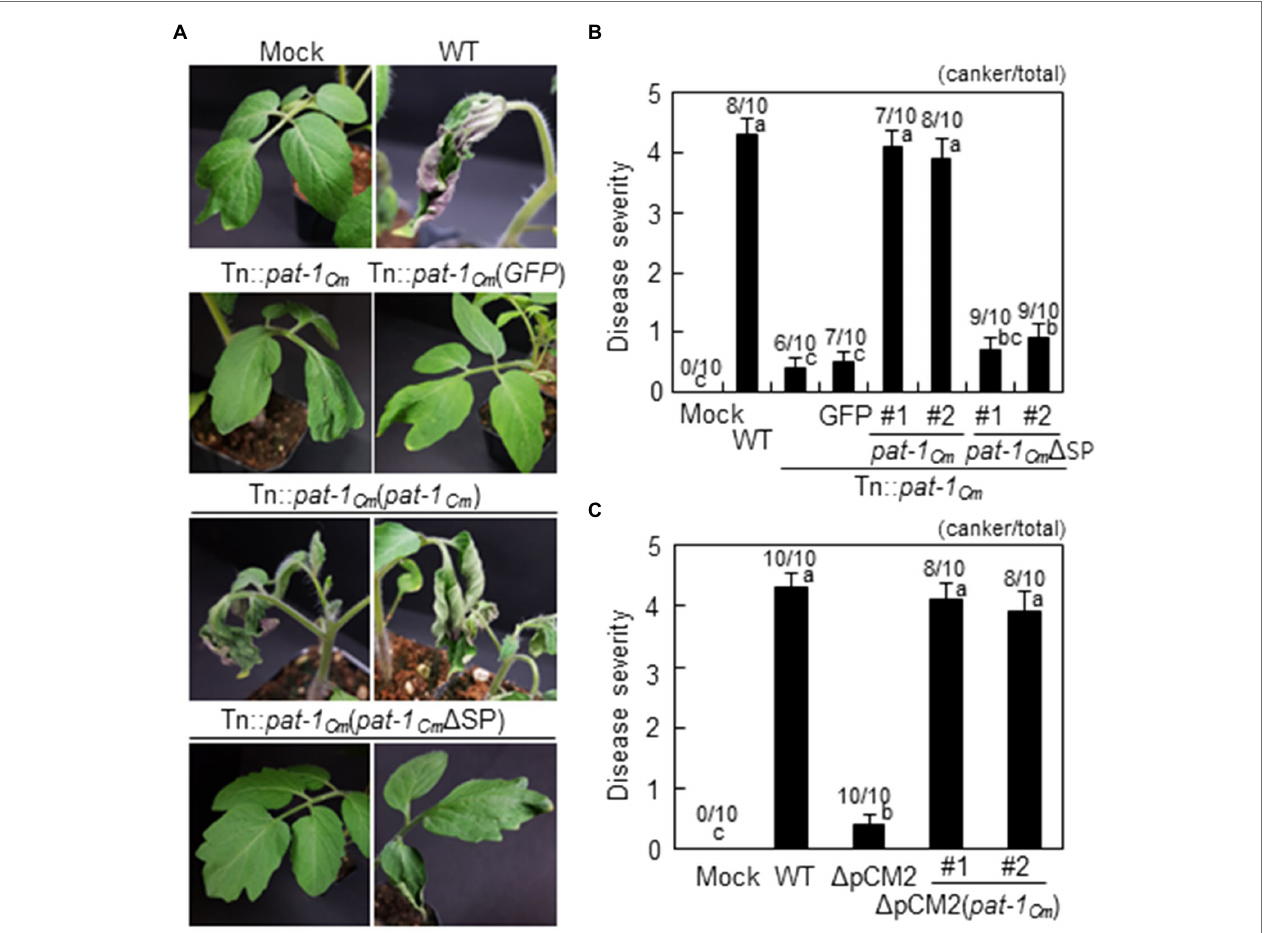
FIGURE 1 | Pathogenicity recovery of Clavibacter michiganensis mutant Tn:: pat-1 Cm transformed with intact pat-1 Cm gene, but not pat-1 Cm Δ SP, in tomato. (A) Disease symptom development in infected tomato plants with indicated strains. Complemented strains was generated by overexpressing either full-length pat- 1 Cm or signal peptide (SP)-lacking pat-1 Cm Δ SP. Two-week-old plants were used, and disease symptoms were photographed 14 days after inoculation (dai). (B,C) Disease severity of wilting in tomato plants inoculated with the indicated strains at 14 dai calculated based on disease index. Moreover, plants with bacterial canker were marked as the number of plants that displayed canker on the stem (canker/total). Error bars indicate SE ( n = 10). Nonparametric Kruskal–Wallis test with Dunnett’s multiple comparisons ( p < 0.05) was used to analyze the level of disease severity in tomato plants, and different letters indicate statistically significant differences at p < 0.05. C. Mock, 10 mM MgCl 2 ; WT, C. michiganensis LMG7333 wild–type